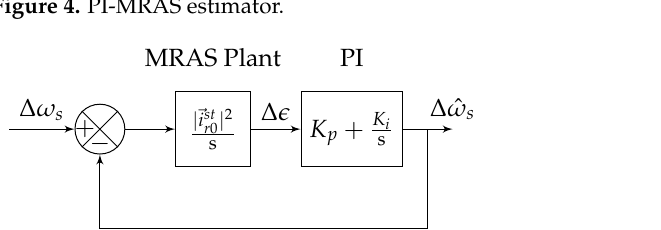
Figure 4. PI-MRAS estimator.